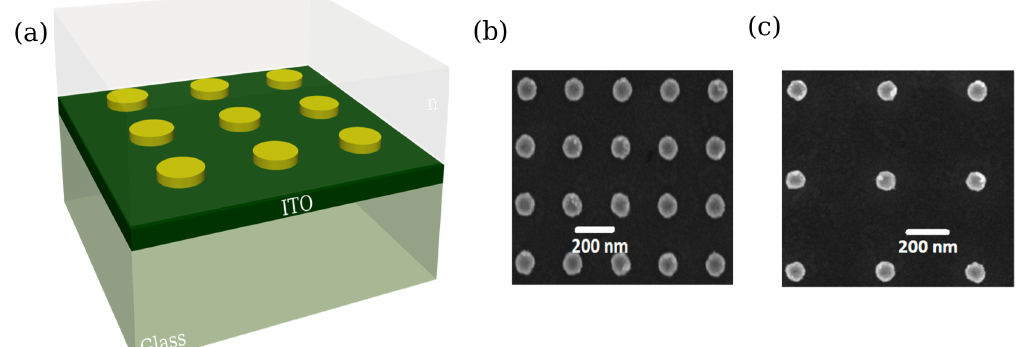
Figure 1. ( a ) Scheme of the gold nanoparticle (NP) array deposited on an indium tin oxyde (ITO) (thickness 80 nm) coated glass substrate and surrounded with a dielectric of refractive index n. ( b , c ) SEM images of gold nanodisc square arrays with a diameter of 100 nm and a grating constant Λ of 250 nm and 450 nm, respectively. Height of the discs h = 50